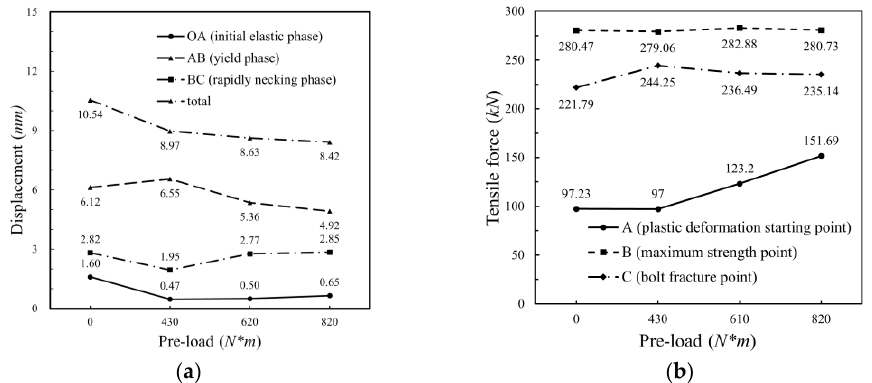
Figure 15. Characterization of the response curve of the bolt tension test in relation to the preload force: ( a ) Tensile displacement in three stages, ( b ) Tensile force values at three transition points.